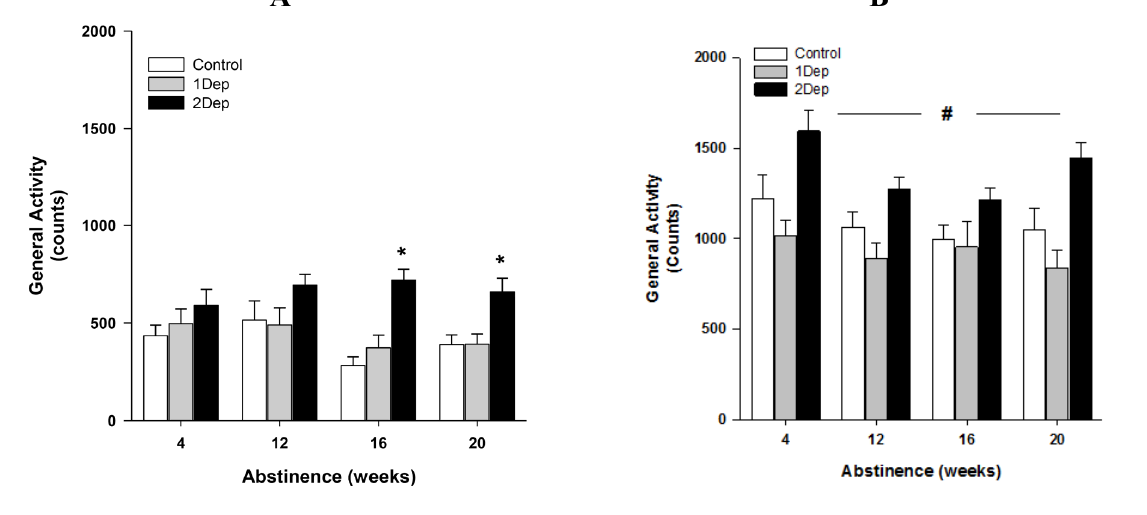
Figure 3. Spontaneous circadian activity at several time-points of heroin protracted abstinence. ( A ) Daytime activity and ( B ) nighttime activity at 4, 12, 16 and 20 weeks in animals with a history of single heroin dependence (1Dep), 2 heroin dependence episodes (2Dep), and in control animals (Control). Points represent mean ± SEM ( n = 5–7/group). ( A ) Total number of beam breaks during the diurnal part of the circadian cycle. ( B ) Total number of beam breaks during the nocturnal part of the circadian cycle. 2Dep animals show persistent diurnal hyperactivity (Fisher’s PLSD 2Dep vs. control group, * p < 0.05). Moreover, 2Dep animals show a global increase of nocturnal activity (main effect Dependence, # p <